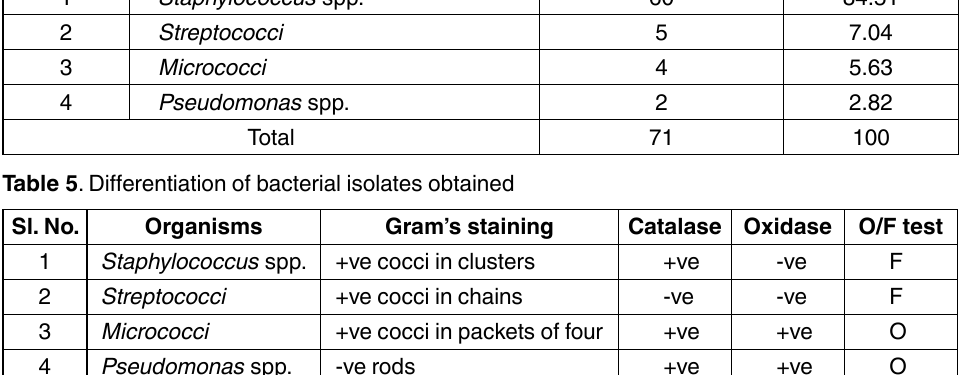
table 4. Number of bacterial organisms isolated from dogs skin sl. No.